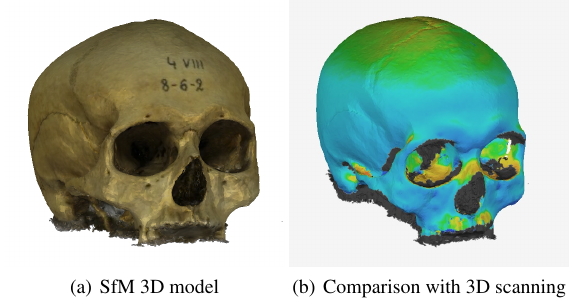
Figure 4. SfM 3D model and comparison with 3D scanning The standard deviation for surface difference is 1.22